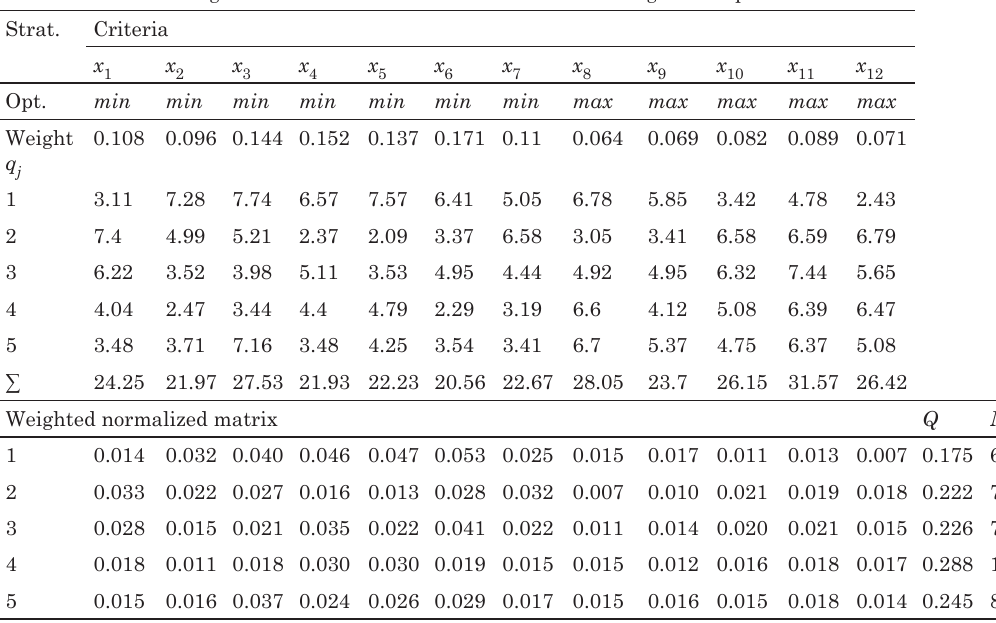
table 7. The problem’s solution according to CoPras method Initial decision-making matrix with values of the attributes describing the compared alternatives strat. opt. Weight